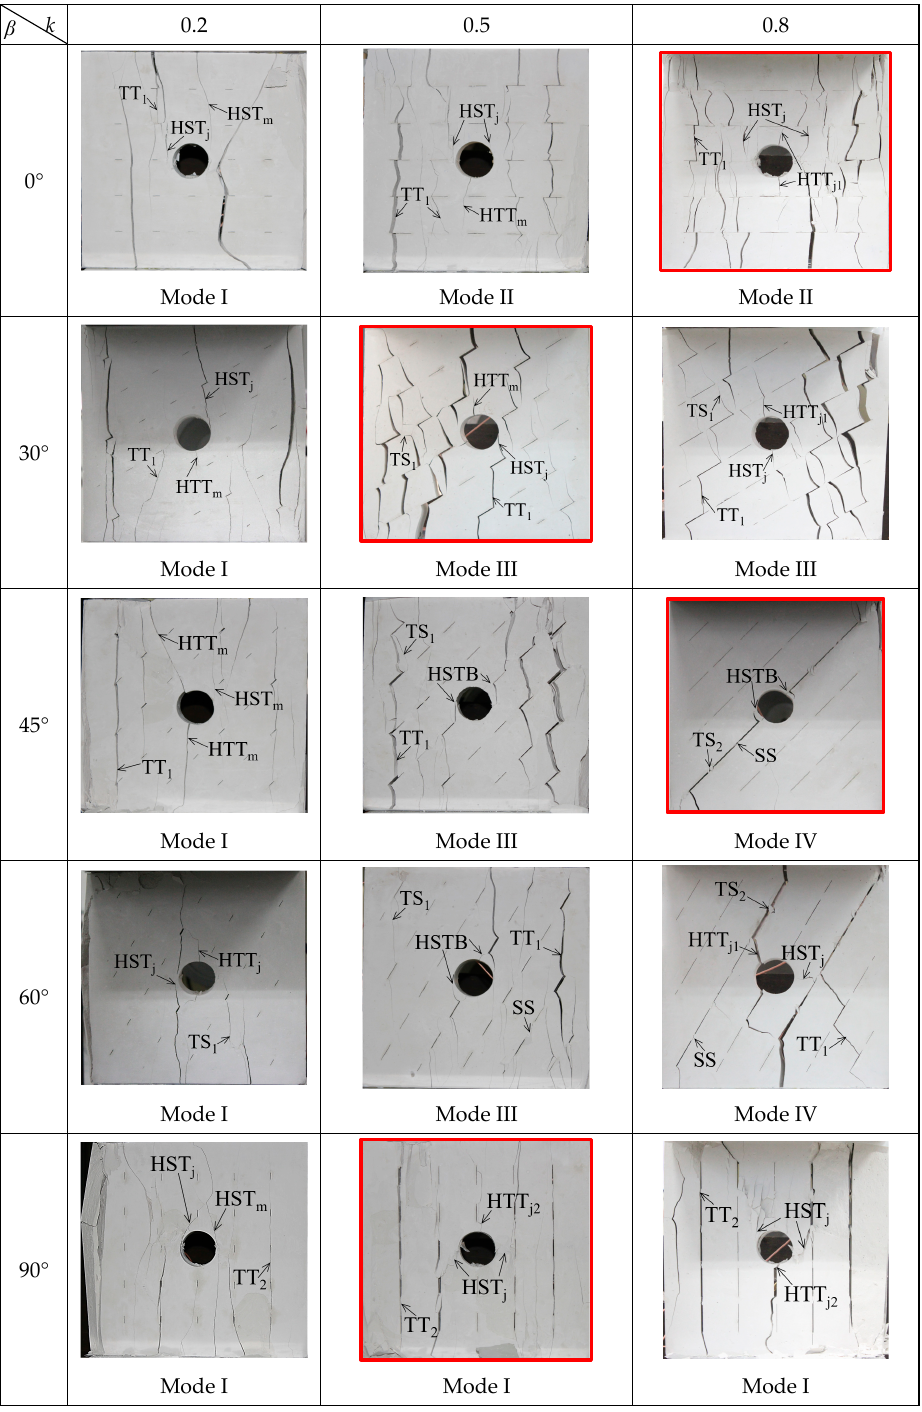
Figure 13. Fractures of all jointed specimens with a hole and their failure modes (the typical speci- mens with different failure modes are marked with the red border).